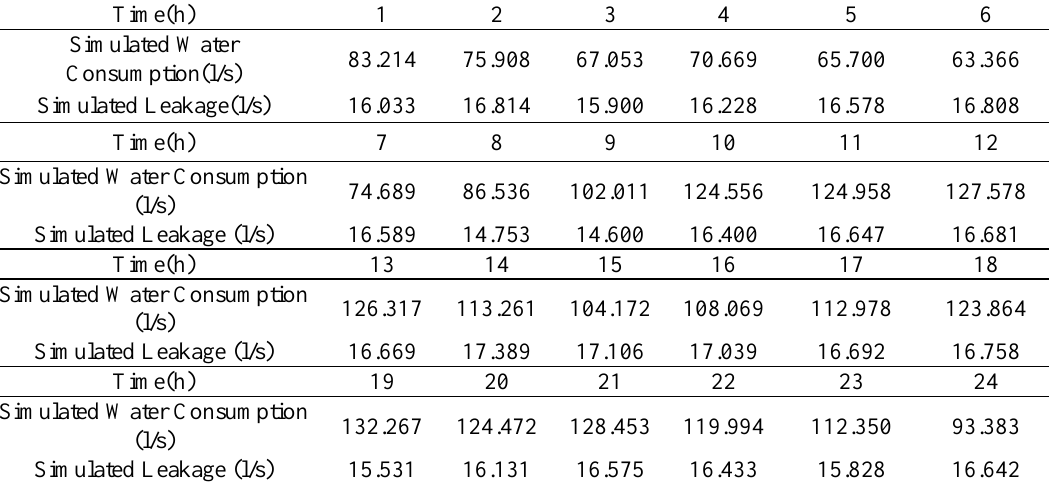
Fig. 8. Variation trend of separated water consumption Table 2. Simulated Water Consumption and Leakage in 24